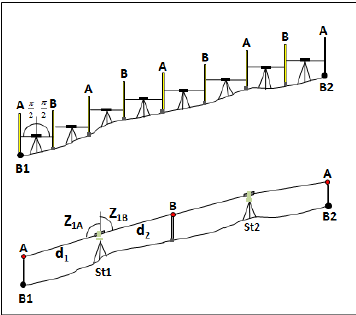
Figure 2. Scheme of spirit levelling and differential trigonometric levelling.